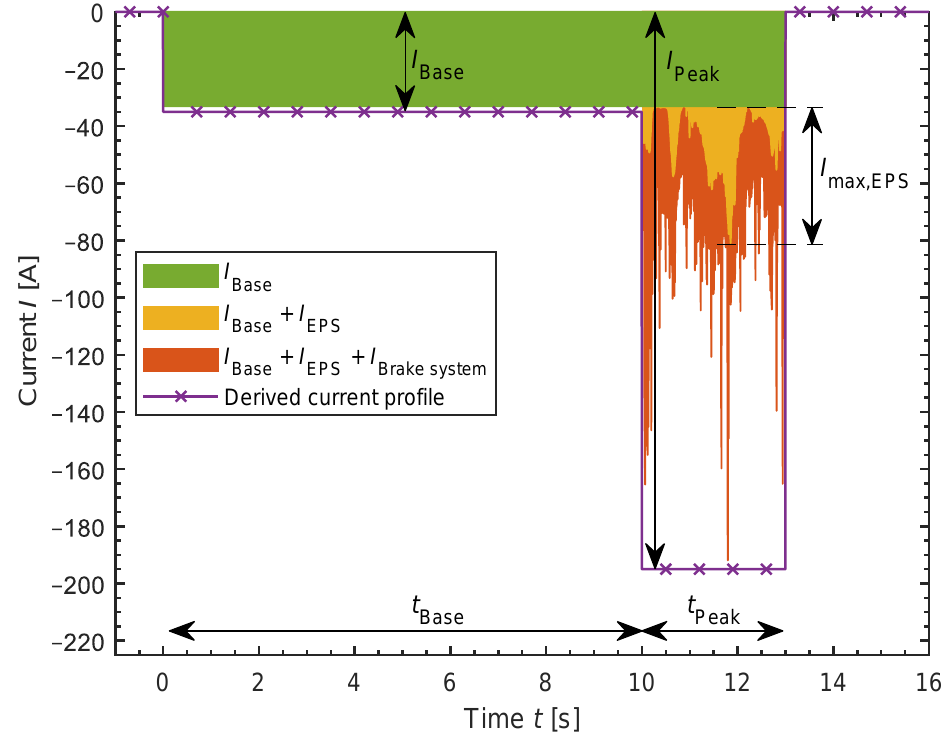
Figure 7. Derivation of the current profile to safeguard the critical driving maneuver based on the current demand from previous simulation. Total current demand results from addition of I EPS , I Brakesystem and I Base